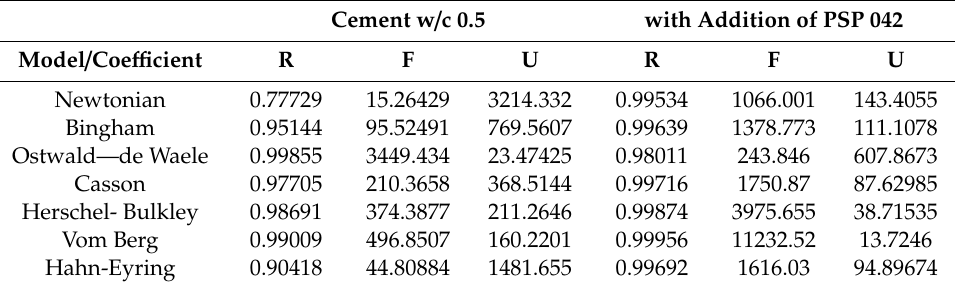
Table 6. Results of the rheological model selection obtained from Rheosolution 4.0 for cement slurry samples (with and without adding